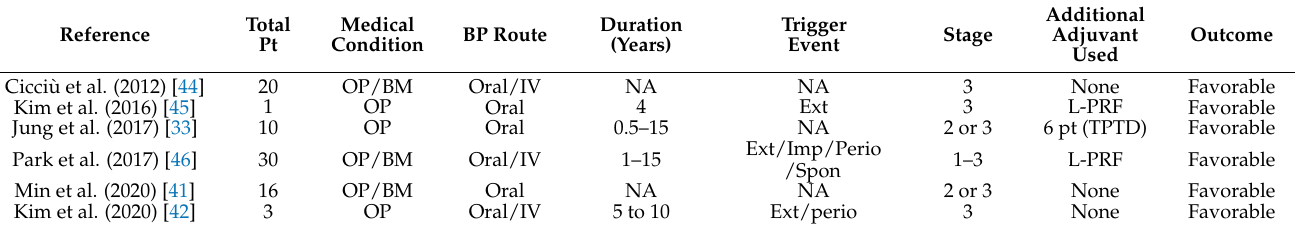
Table 2. Human studies of recombinant human bone morphogenetic protein-2(rhBMP-2) administra- tion for MRONJ treatment in the past 10